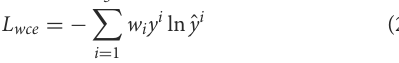
image is fed into the pre-trained DCNN to extract the feature